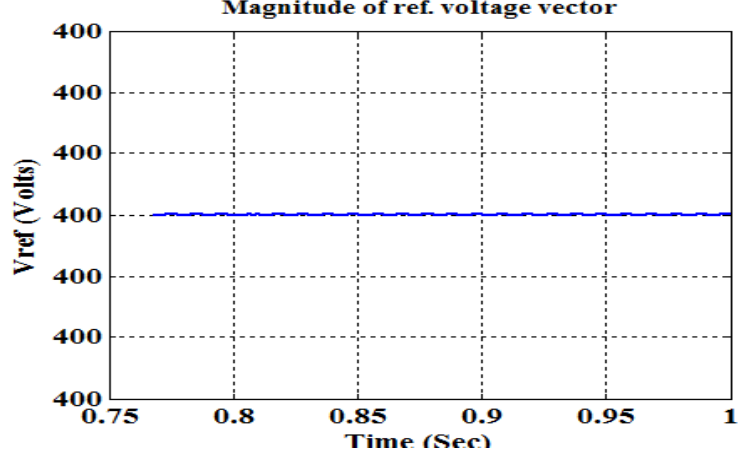
Figure 9. The direct current (DC) link voltage response.